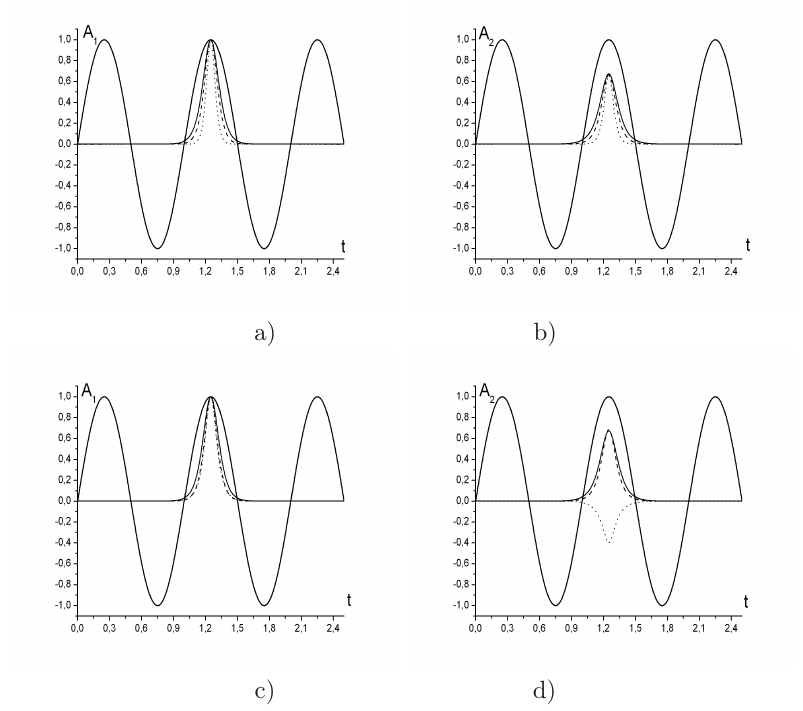
Figure 4. Shape of pulse for solitary wave on fundamental (a,c) and doubled (b,d) frequency corresponding to the first eigenvalue under the fixed value δ α = 0 (a,b) for n γ = 5 , δ γ = 0 (solid line), δ γ = 1 (dashed line), δ γ = 5 (dotted line) or under the fixed value δ γ = 0 (c, d) for n α = 5 , δ α = 0 (solid line), δ α = 1 (dashed line), δ α = 5 (dotted